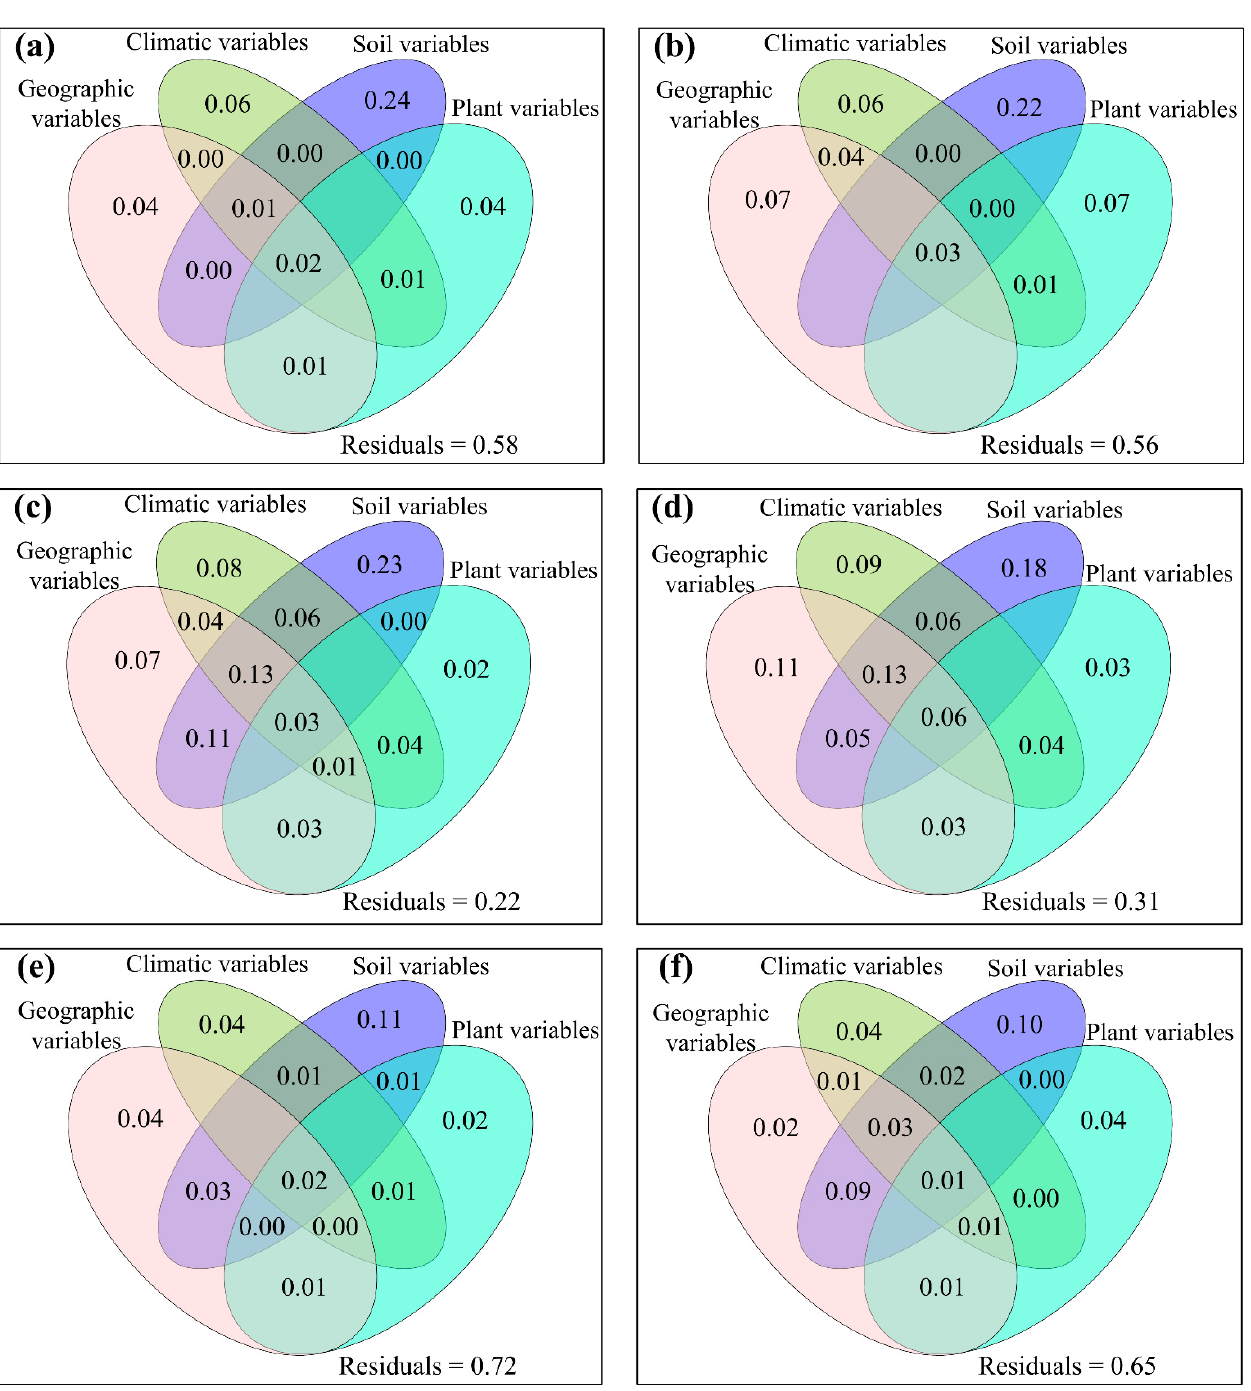
Figure 9. The mutual as well as excluded impacts of geographic variables, climatic variables, soil variables and plant variables on ( a , b ) species β -diversity, ( c , d ) phylogenetic β -diversity, and ( e , f ) function β -diversity of soil fungal community for ( a , c , e ) topsoil and ( b , d , f ) subtopsoil, respectively.